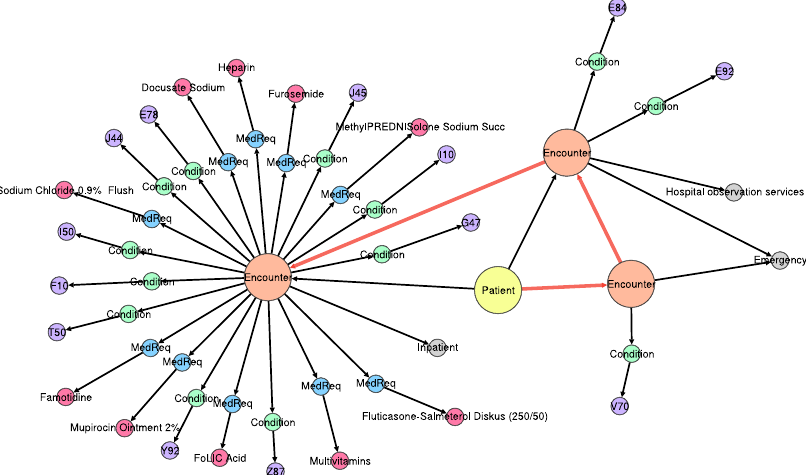
Fig. 1 Visualization of a patient trajectory. Each trajectory is represented as a directed acyclic graph. The patient timeline is represented by the edges between Encounters (highlighted in